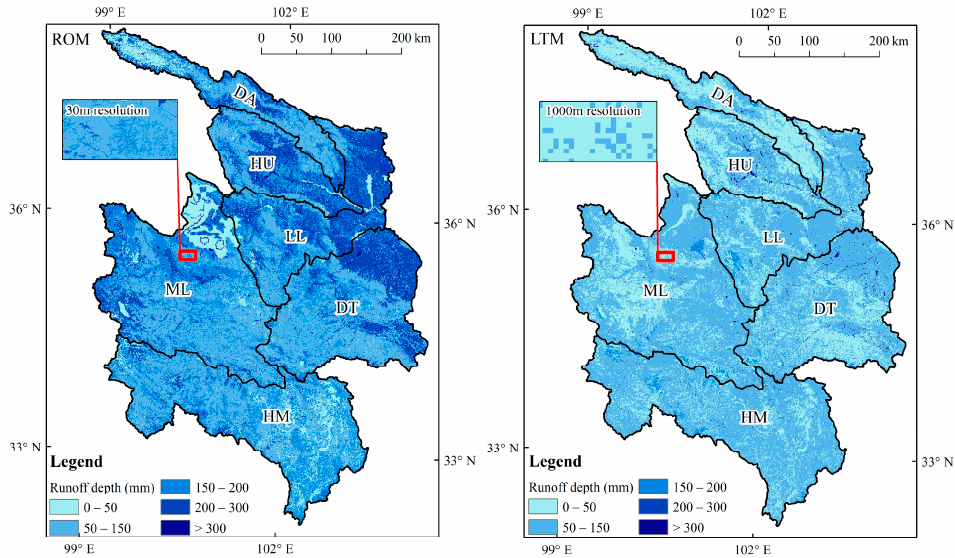
Figure 4. Spatial distribution of runoff depth calculated by two methods.